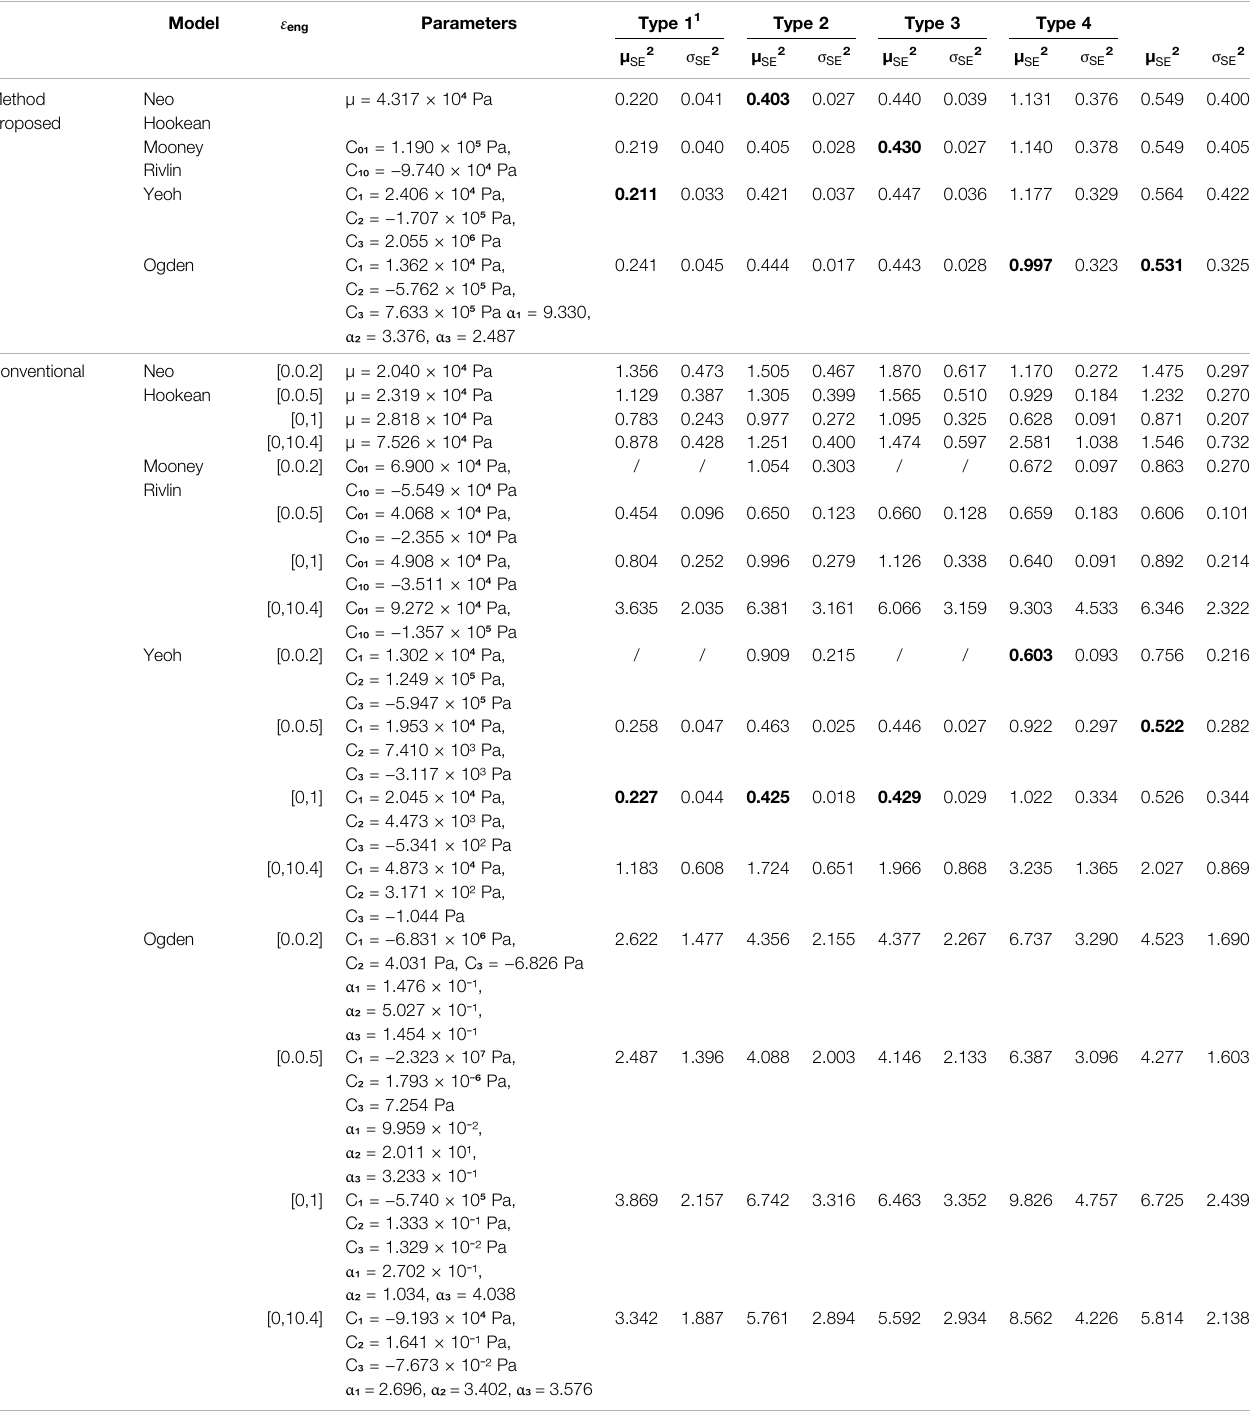
TABLE 5 | Results for Dragon Skin ™ 10